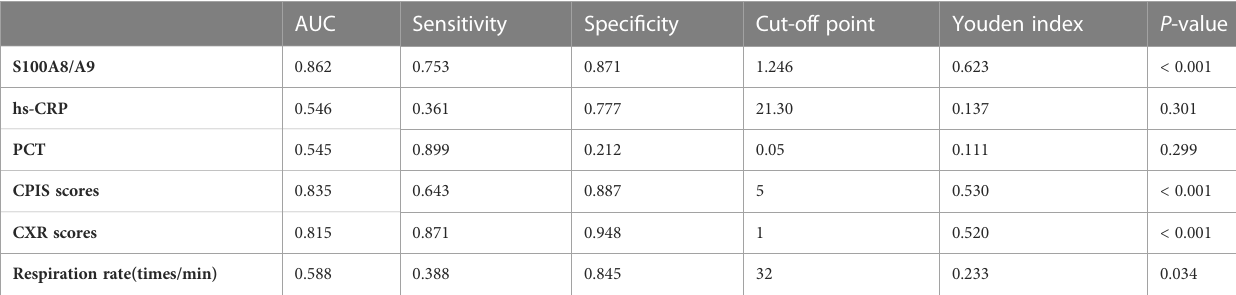
TABLE 5 Evaluation of indicators re fl ecting the effectiveness of the diagnosis between mild CAP and severe